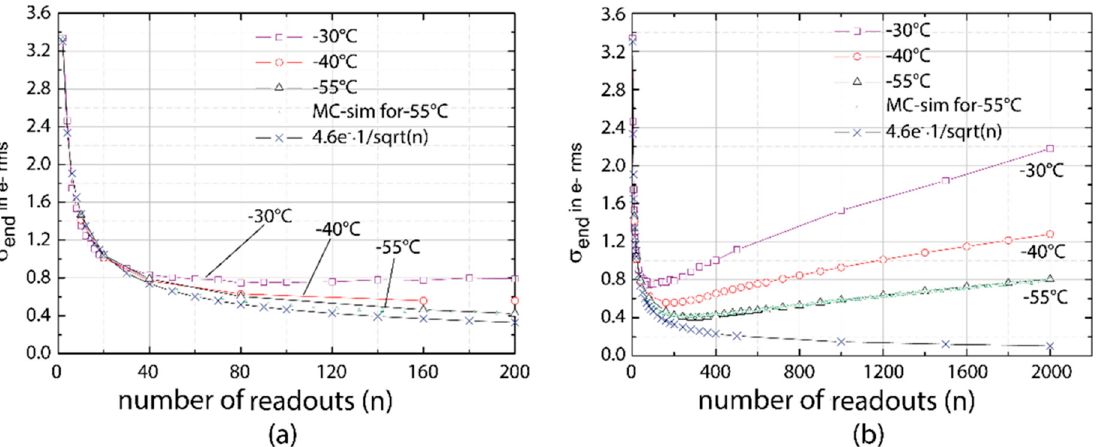
Figure 8. Experimental confirmation of the noise reduction due to multiple readouts using a fixed readout time of τ SINGLE = 25.5 μ s. For a single readout (n = 1) the readout noise for was σ SINGLE = 4.6 e − ( a ) Between 2 and 40 repetitive readouts the read noise follows approximately the expected behavior σ end = σ SINGLE /sqrt(n) = 4.6 e − /sqrt(n); ( b ) For larger n values, the read noise is dominated by the